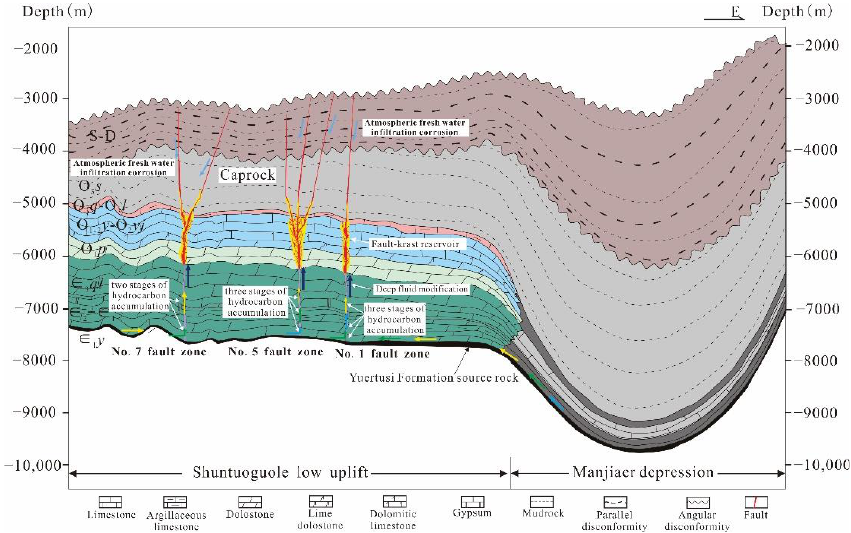
Figure 12. The hydrocarbon accumulation model for the Shunbei area (modified after Sinopec Northwest China Petroleum Bureau).